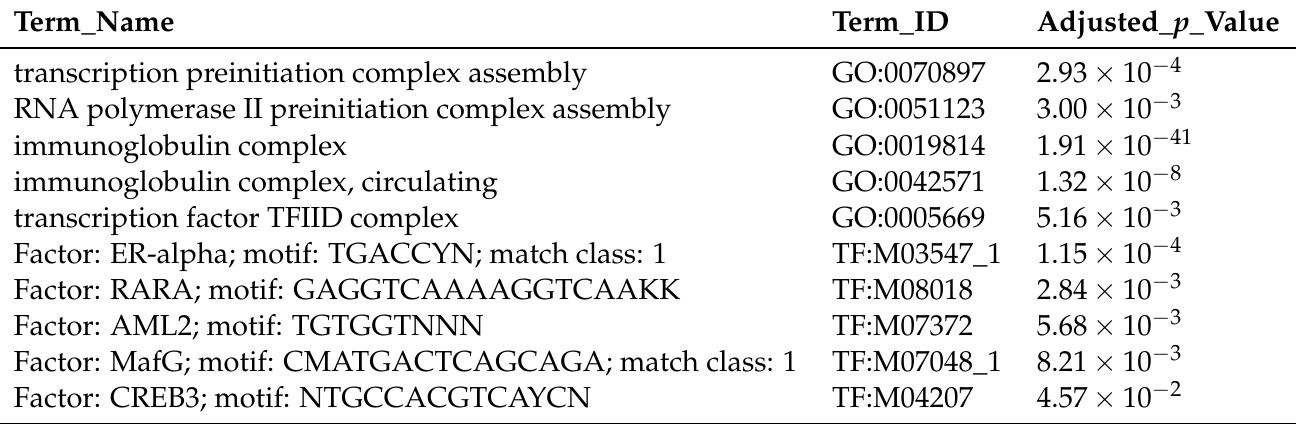
Table 2. Results of enrichment analysis of 120 min Hi-C data by